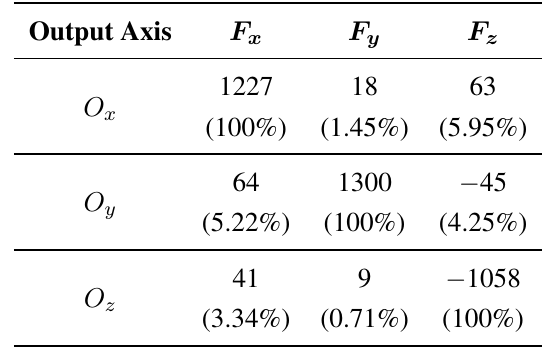
Table 2. Example of sensor readings for a full-scale load in each direction (cross-talk performance in